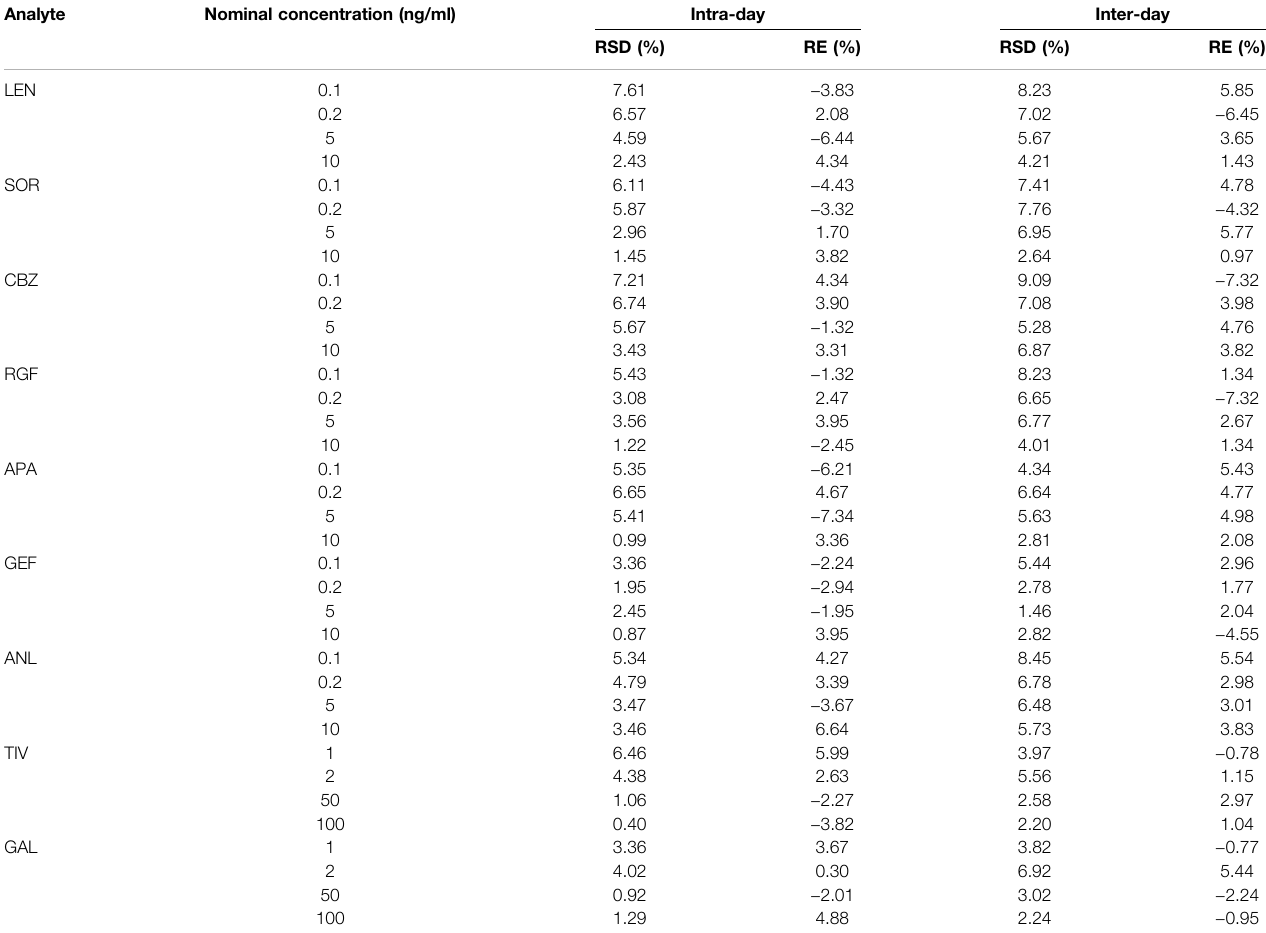
TABLE 3 | Results for intra-day and inter-day precision (RSD) and accuracy (RE) of QC and LLOQ samples ( n = 6). Analyte Nominal concentration (ng/ml) Intra-day Inter-day